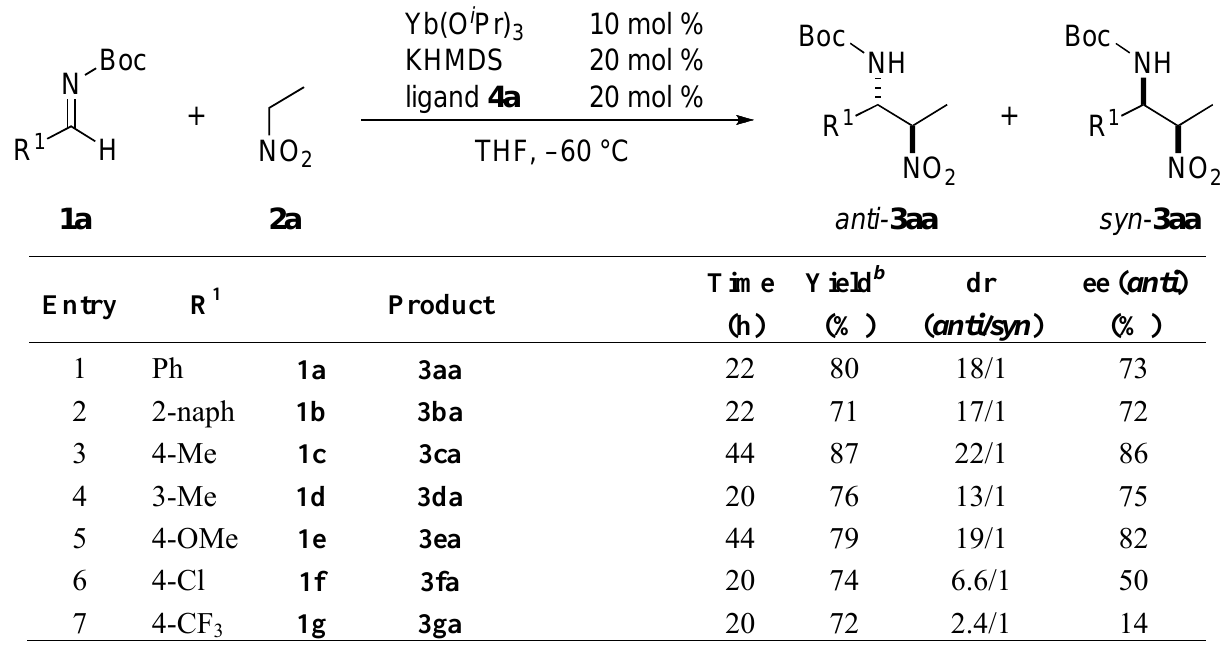
Table 5. Substrate scope of nitro-Mannich reaction promoted by Yb/K/ 4a heterobimetallic catalyst.